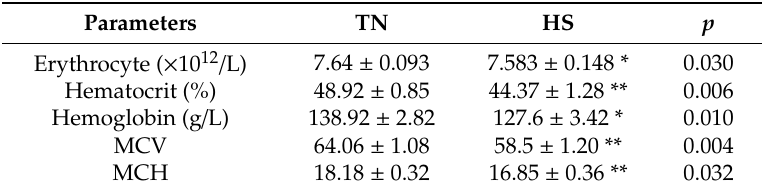
Table 1. The e ff ects of three weeks of thermal neutral (TN) or heat stress (HS) conditions on whole blood erythrocyte, hematocrit, hemoglobin, MCV, and MCH in the finishing